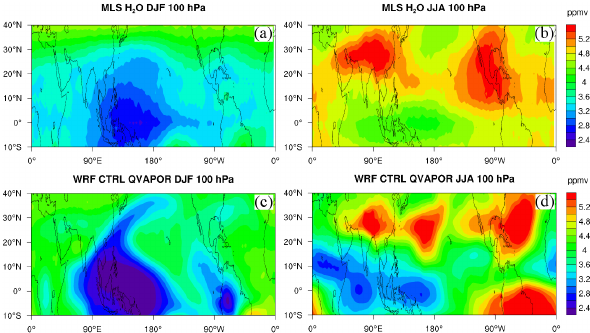
Fig. 3. 4-yr averaged LWCF (Wm − 2 ) at the TOA. (a) CERES in DJF; (b) CERES in JJA; (c) WRF CTRL in DJF; (d) WRF CTRL in JJA. White represents missing data in the CERES